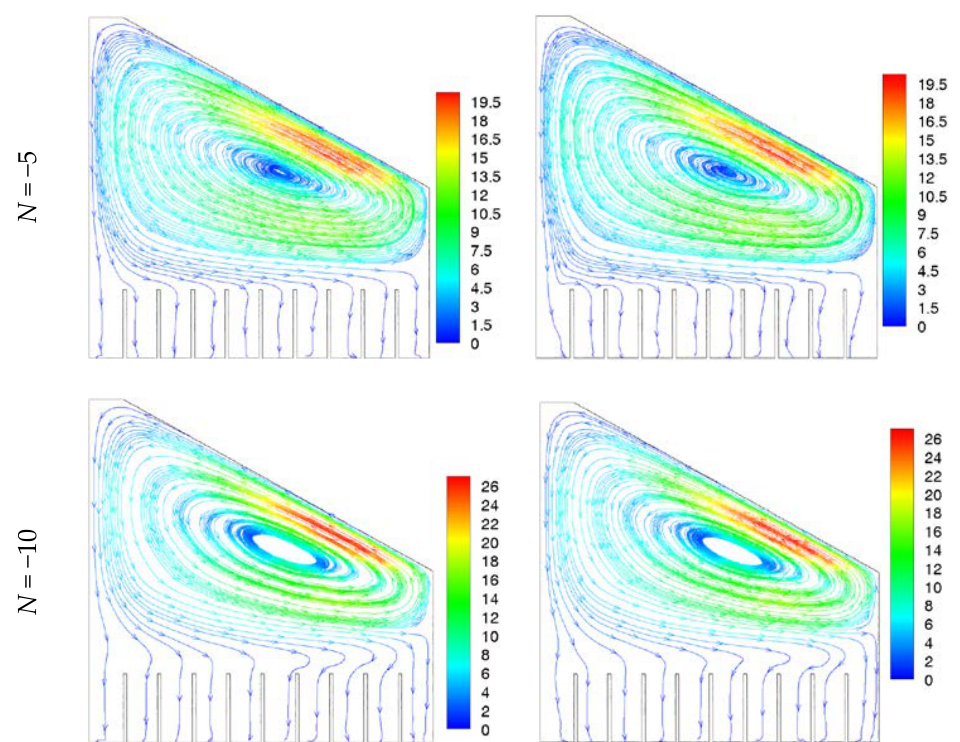
Figure 6. Effect of the buoyancy and conductivity ratios on the main central flow structure for Ra = 10 5 .